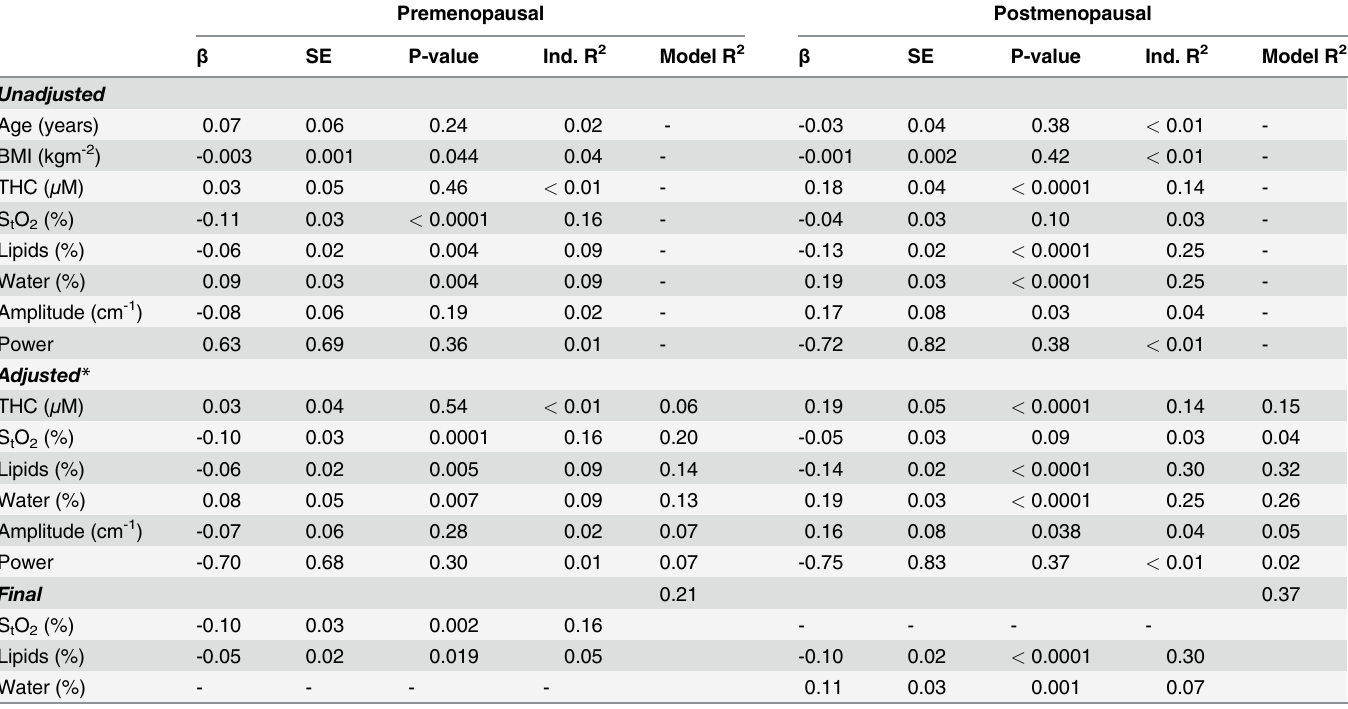
Table 5. Unadjusted, adjusted (for age and BMI) and fi nal regression coef fi cients ( β ) and SEs for breast tissue optical properties with dense area (square root transformation) for 95 pre-and 107 post-menopausal